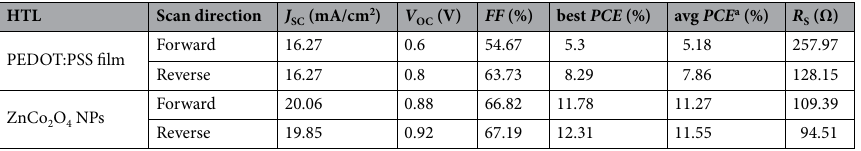
Table 1. Device performance of all PSCs based on PEDOT:PSS film or ZnCo 2 O 4 NPs as the HTL. a Average PCE values were obtained from 20 devices.